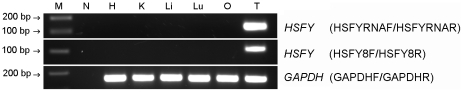

HSFY expression in different tissues.
HSFY was analyzed in a variety of tissues including testis (T), lung (Lu), heart (H), liver (Li), kidney (K) and ovary (O) using real time PCR and two different HSFY primer sets to amplify the gene as well as the reference gene, GAPDH. The results show that both HSFYRNA (HSFYRNAF/HSFYRNAR) and HSFY8 (HSFY8F/HSFY8R) primer sets amplify HSFY only in the testis and no other tissue. All tissues show expression of GAPDH. M) 100 bp ladder (Invitrogen Canada Inc.).